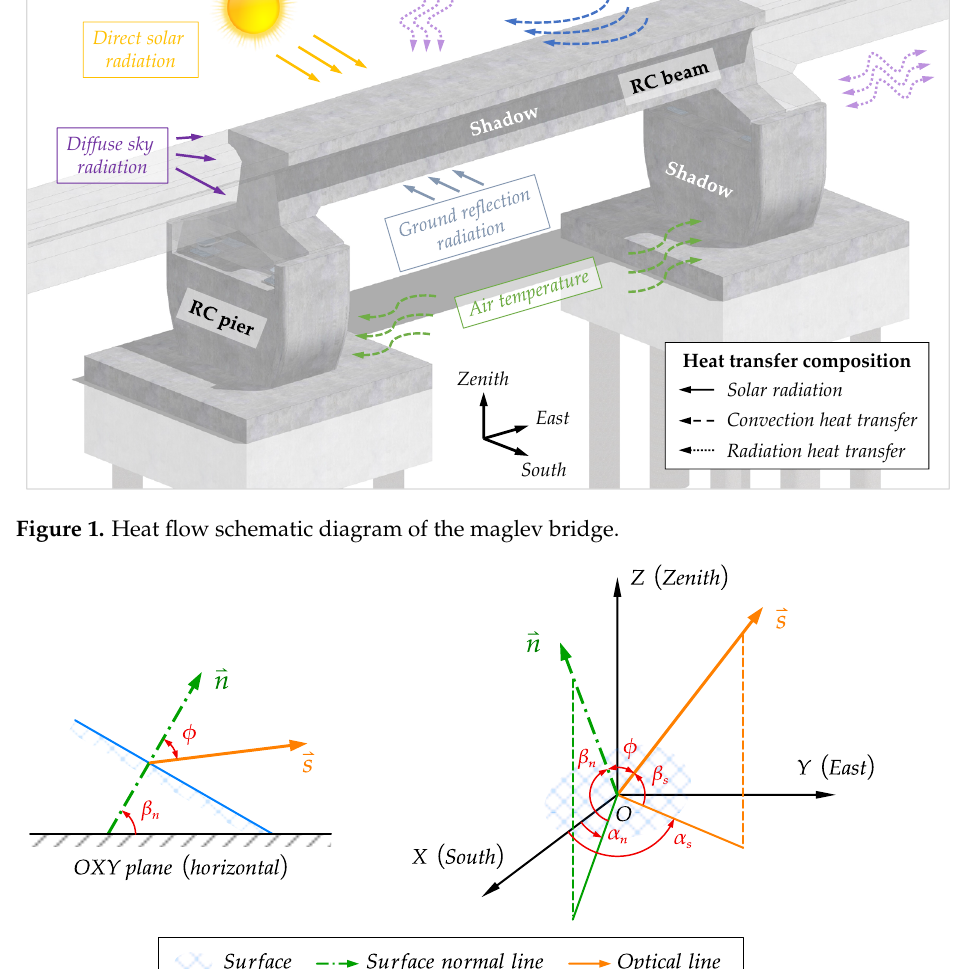
Figure 1. Heat flow schematic diagram of the maglev bridge.